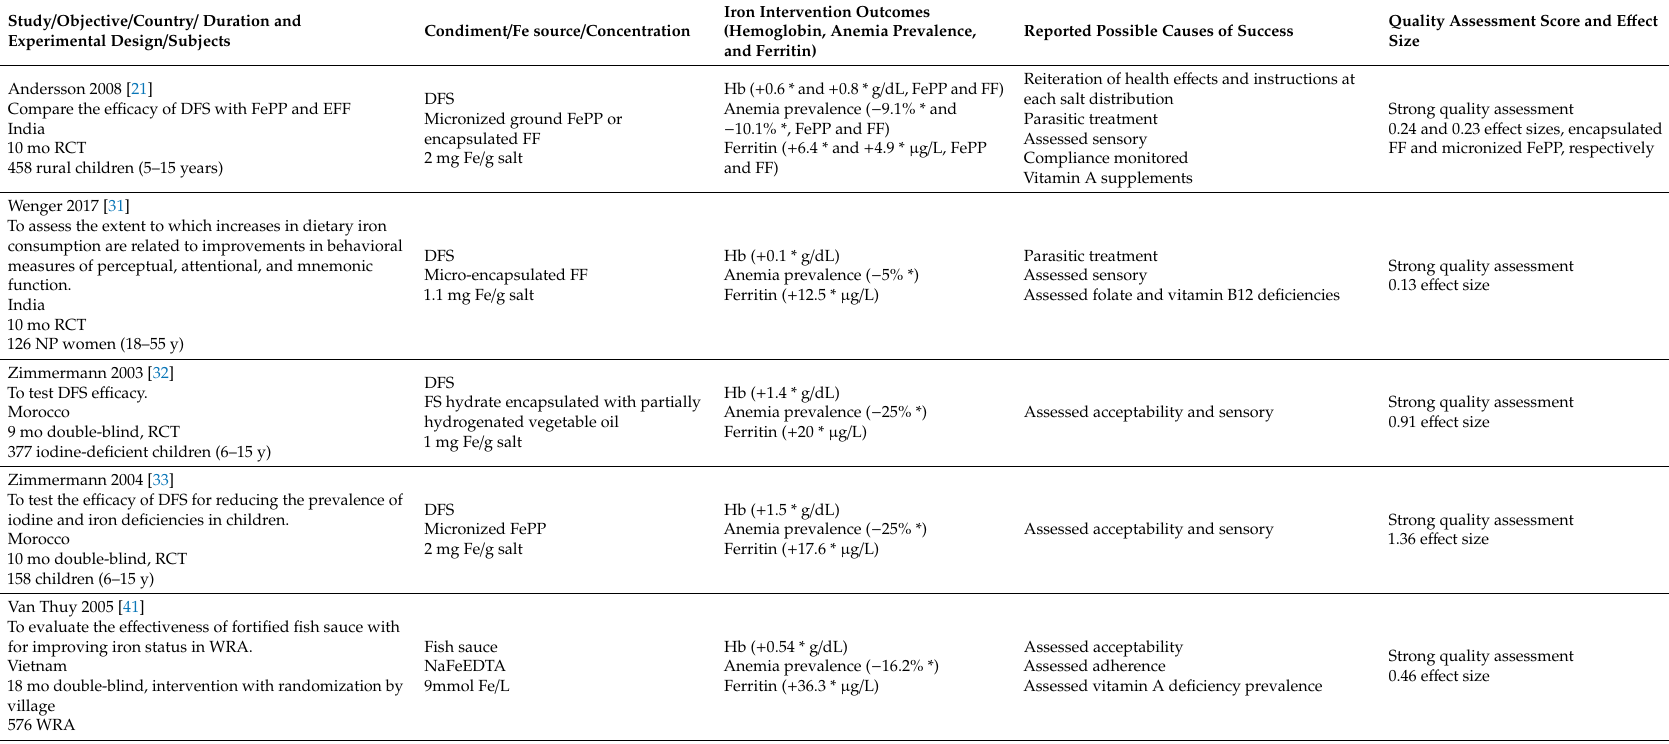
Table 4. High-performing studies of the e ffi cacy of iron fortification of condiments. Studies were selected because all iron indicators (hemoglobin, anemia prevalence, and ferritin) demonstrated a positive